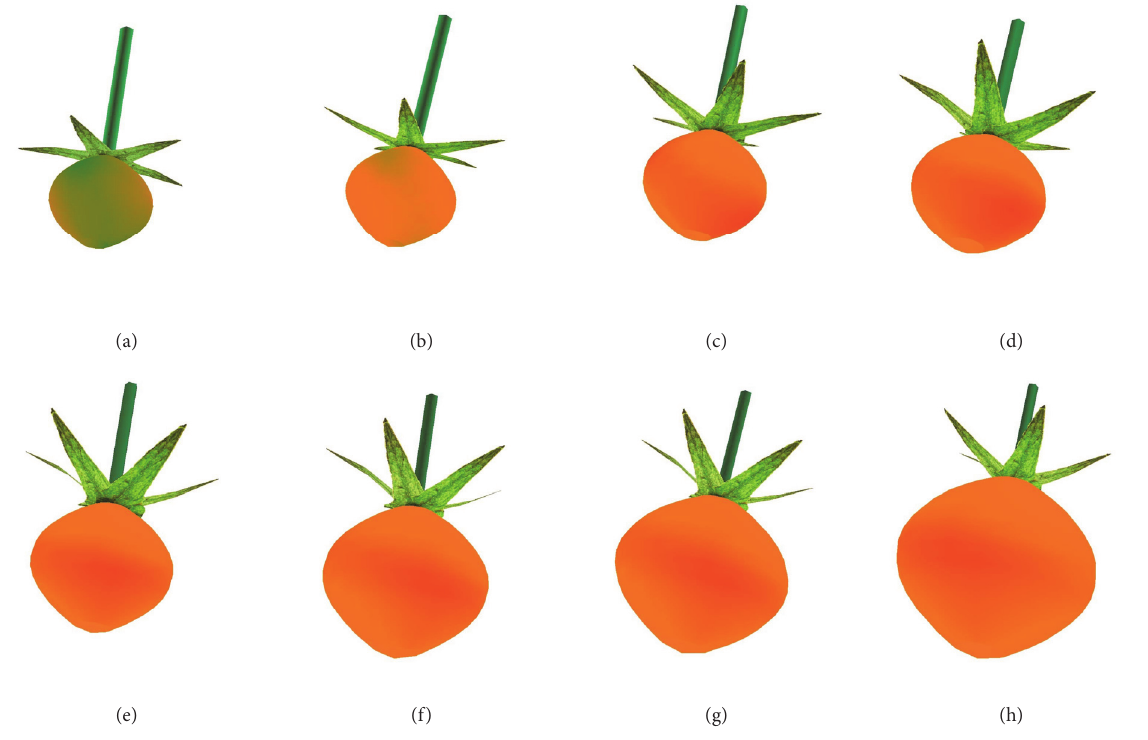
Figure 6: Several frames illustrate a fruit